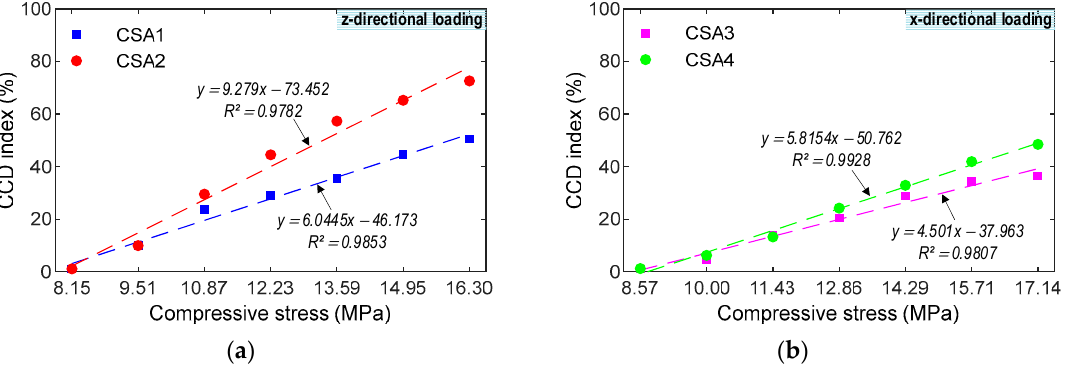
Figure 19. Experimental correlation estimation between CCD index and compressive stress. ( a ) z- directional loading. ( b ) x-directional loading.